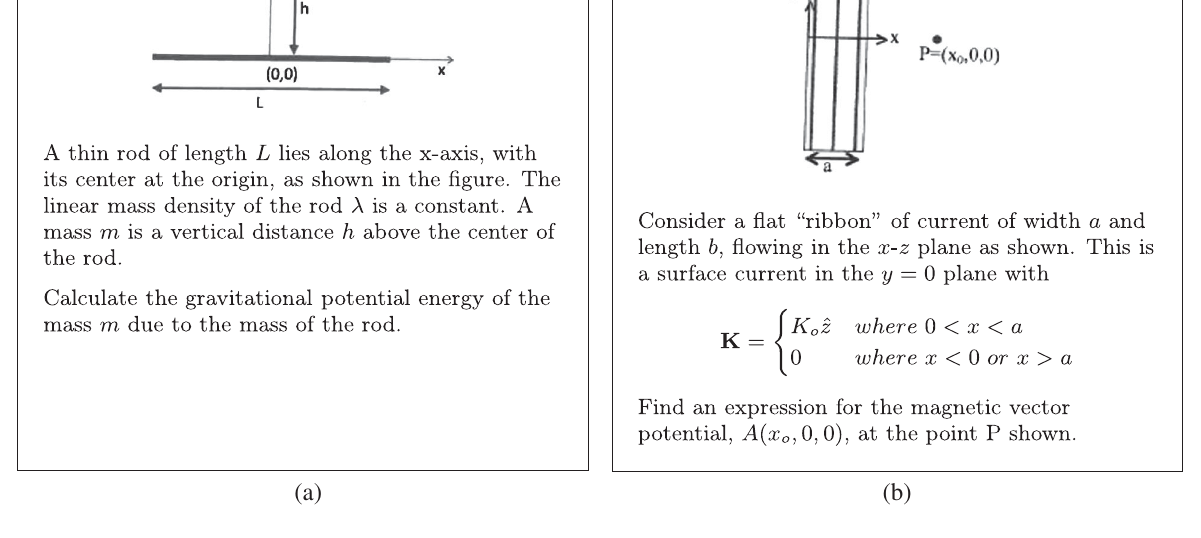
FIG. 1. Examples of the exam questions used in the study. Variations on (a) included asking instead for the scalar potential from a short rod of charge or for the vector potential from a short line segment of